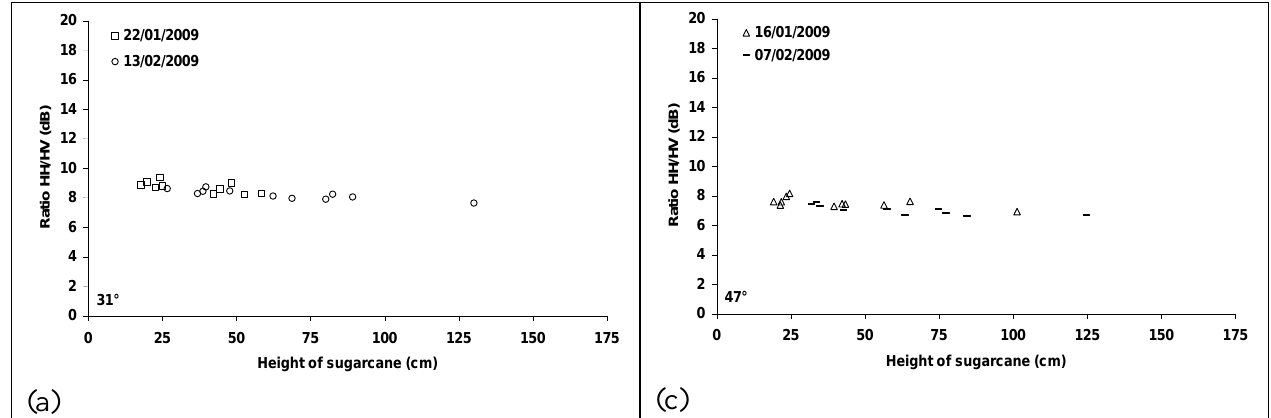
Figure 5. Ratio of TerraSAR-X signals HH/HV and VV/VH and at 31° and 47°. The sugarcane height corresponds to the height of terminal visible dewlap